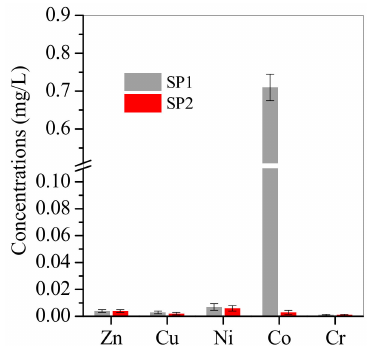
Figure 5. Heavy metals released from SP1 / SP2 after electroplating wastewater